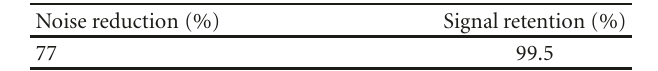
Figure 7: Bar graph comparison of RMSE for EMD-based and raw single trials. Lower RMSE indicates better